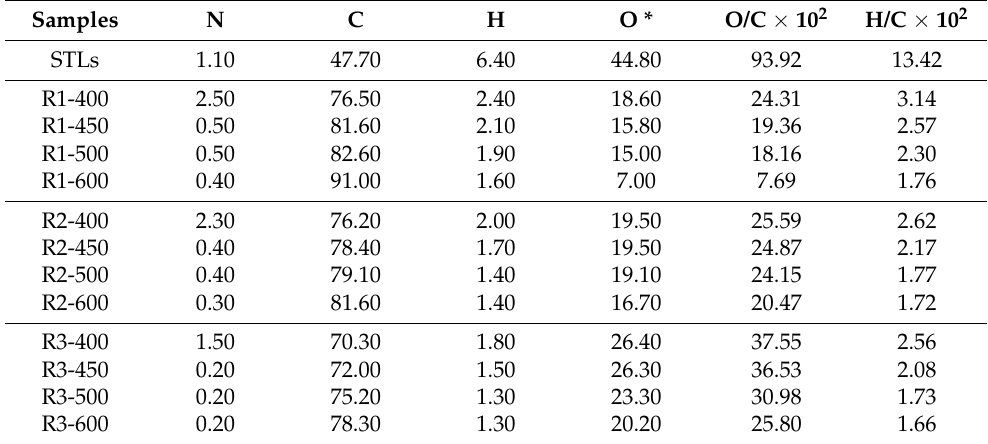
Table 2. Elemental analysis of the precursor and activated carbons produced at different activation temperatures and impregnation ratios